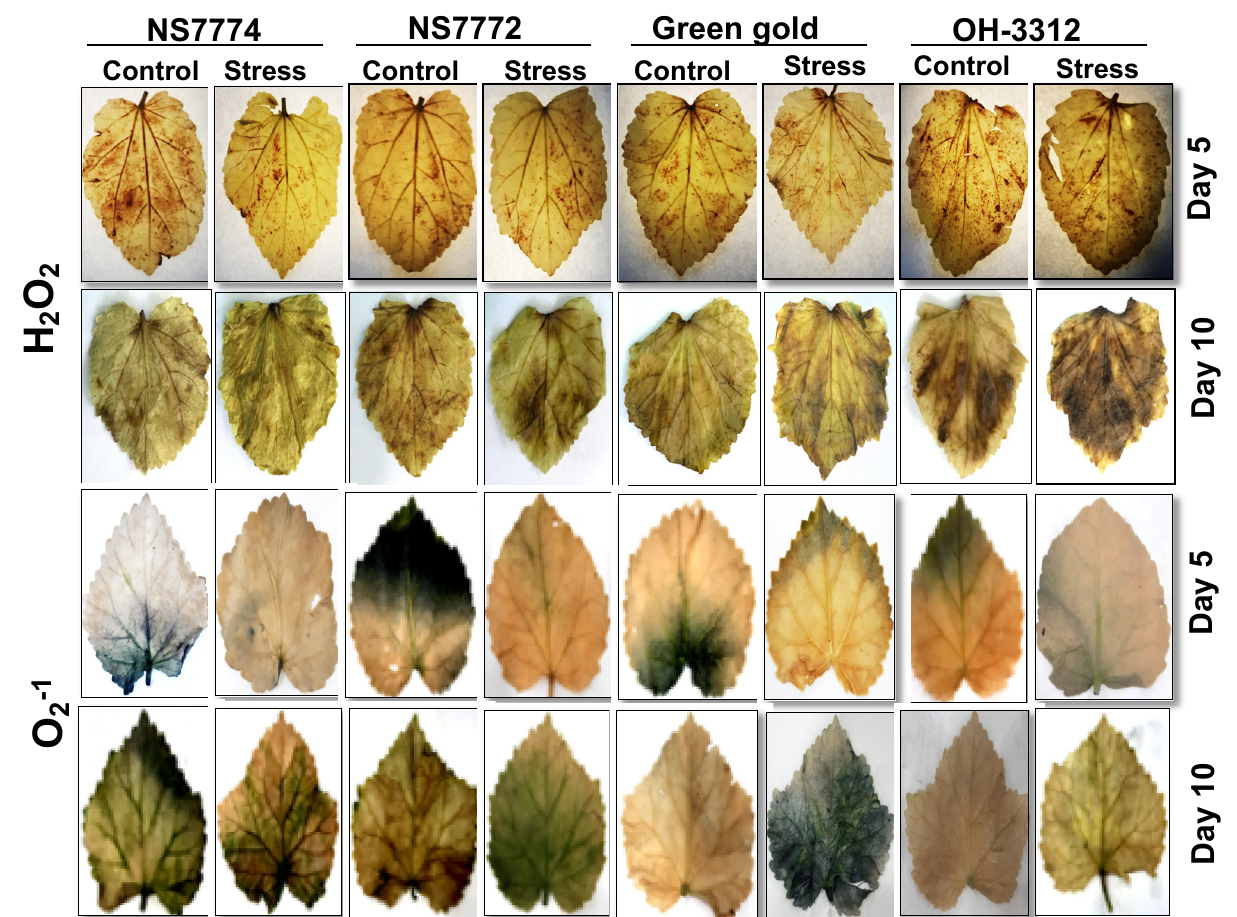
Figure 4. Histochemical localization of oxidative stress markers H 2 O 2 and O 2 − , as affected by drought stress at 5 and 10 days of interval in okra genotypes NS7774, NS7772, Green Gold, and OH3312, along with respective controls. The brownish colour on the leaves indicates the localization of H 2 O 2 stress marker, whereas the bluish colour indicates the localization of O 2 − 1 marker.